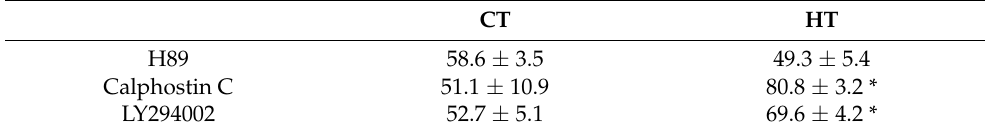
Table 3. Inhibition of EFS-induced NO release after preincubation with the PKA inhibitor H89 (1 µ mol/L), with the PKC inhibitor Calphostin C (0.1 µ mol/L) or with the PI3K inhibitor LY294002 (10 µ